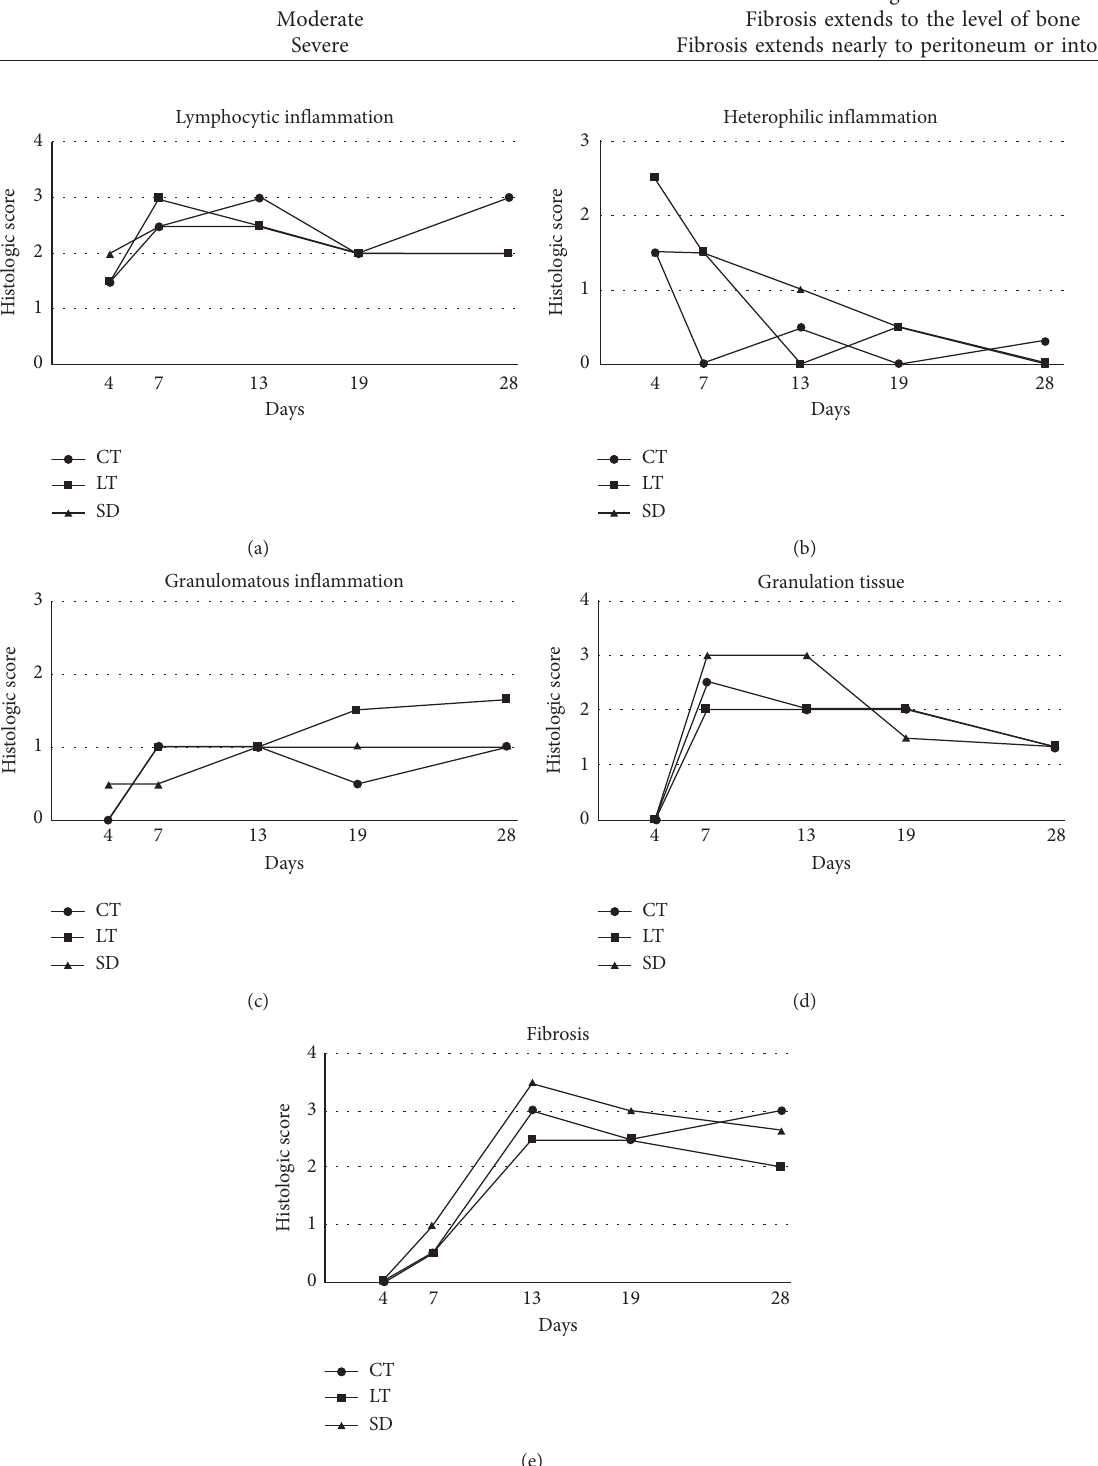
Figure 1: Histologic scores for inflammation, granulation tissue, and fibrosis over time in surgically induced 6mm diameter full-thickness dermal wounds in marine toads ( Rhinella marina ) treated with low-level laser therapy (LT), topical silver sulfadiazine (SD), or untreated controls (CT). Scores represent an average of two toads from each treatment group for days 4–19. Scores represent an average of three toads from each treatment group for day 28.